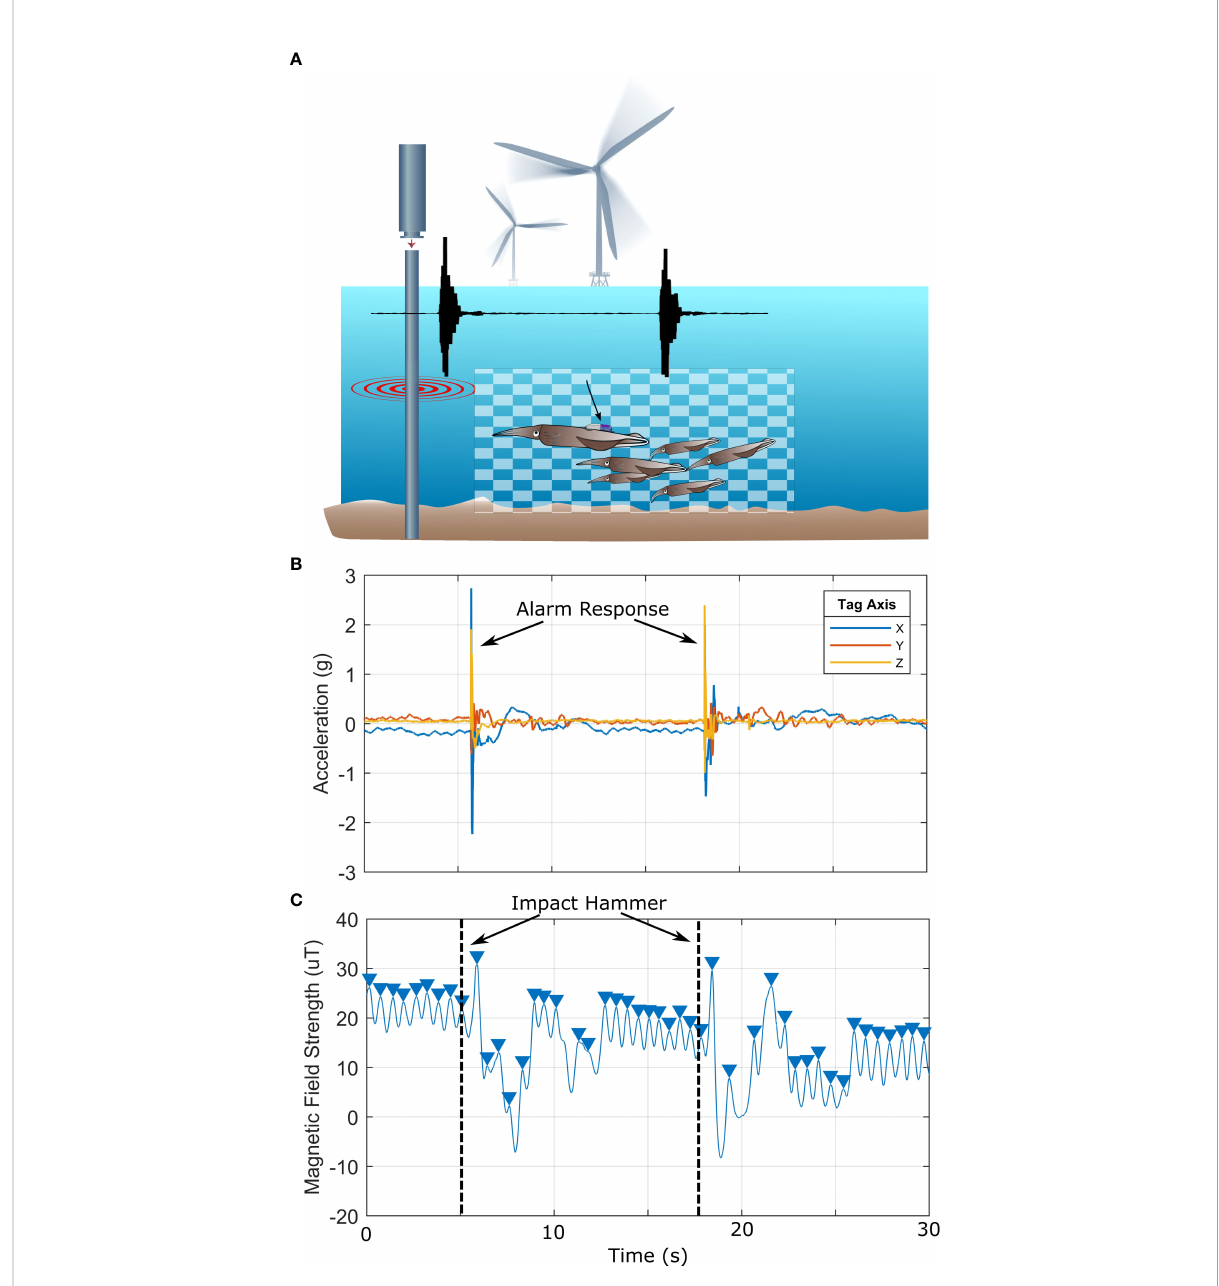
FIGURE 4 Squid elicit alarm behaviors in response to pile driving sound. (A) A schematic of the experimental setup with an overlaid example impact hammer signal. Black arrow highlights tagged large squid. (B) Focal tagged squid acceleration during a typical kinematic disturbance. Heightened acceleration occurs at the moment of the impact hammer strike. (C) Concurrent magnetic fi eld strength data used to calculate fi nning rate. Magnetic fi eld strength is a consistent sinusodial signal before impact hammer, but becomes irradic as the focal squid transitions to jet propulsion